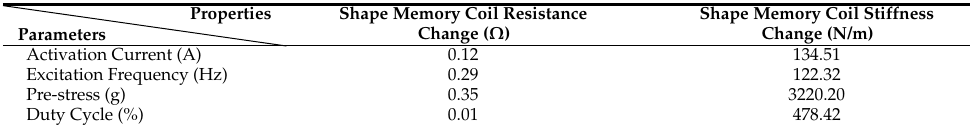
Table 16. Resistance and stiffness values at different Influencing factors.